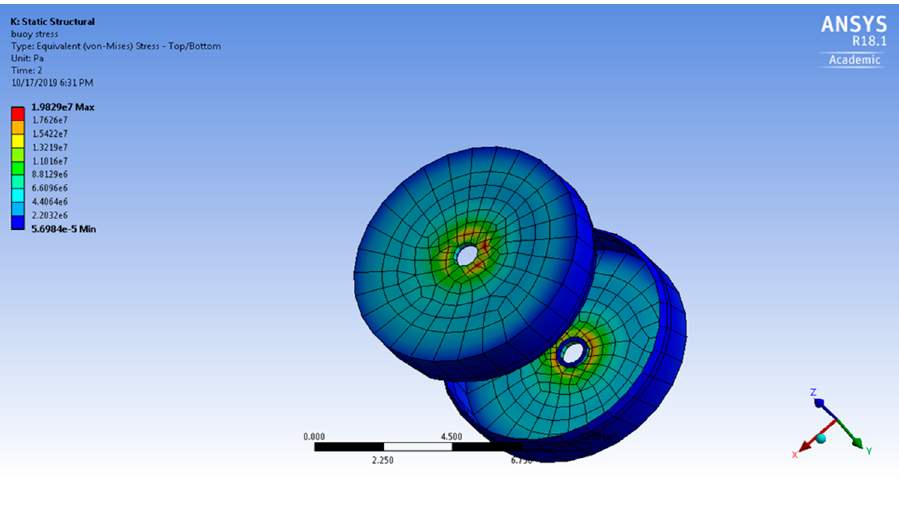
Table 7. Sea states and number of stress cycles.